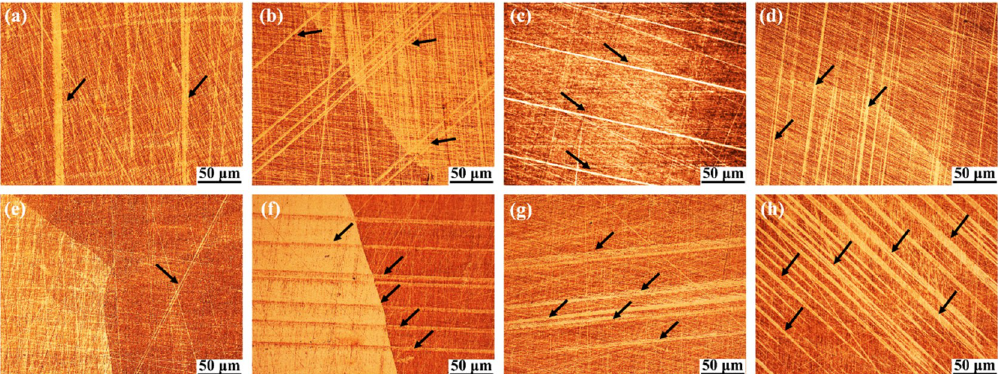
11 of 13 Figure 12. Transformation temperatures on DSC samples after different cryogenic pre-deformations. Note: A = ( A s + A f )/2; M = ( M s + M f )/2. 3.4. TWSME and Martensite Morphology